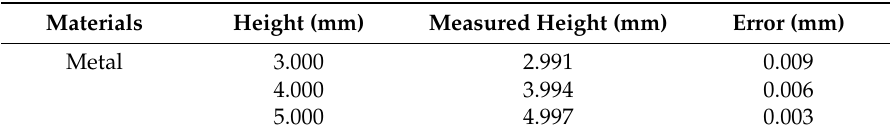
Figure 8. Experimental results on gauge blocks. ( a ) demonstrates the gauge block standards. ( b ) illustrates the measured 3-D data. Table 2. Experimental data on metal gauge Table 2. Experimental data on metal gauge blocks.